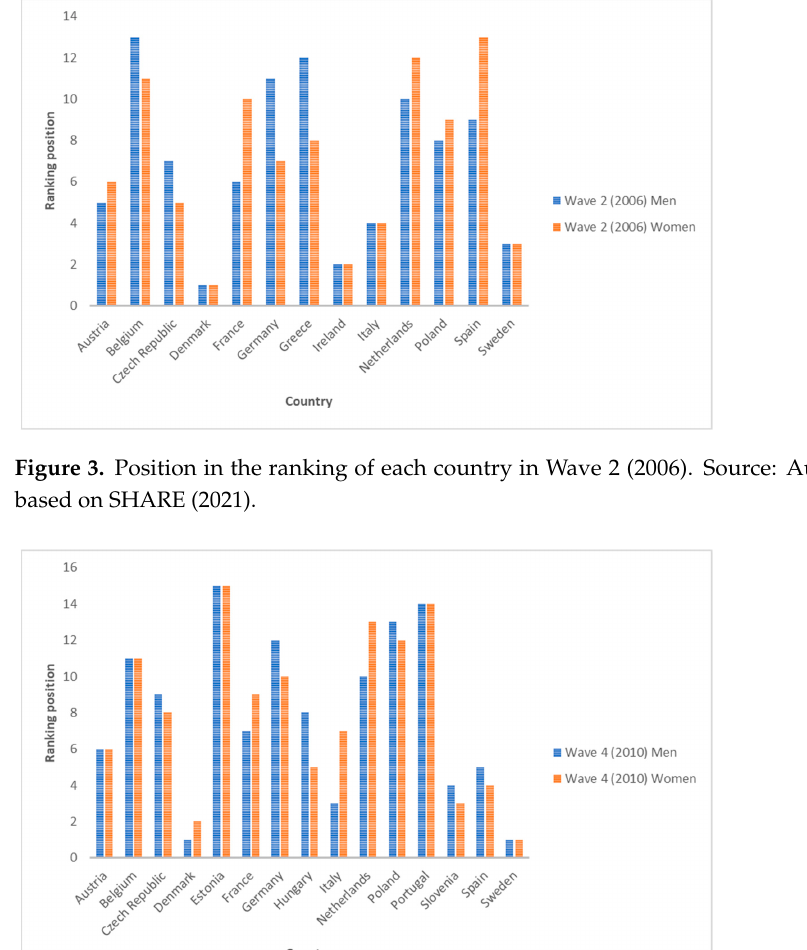
Figure 4. Position in the ranking of each country in Wave 4 (2010). Source: Authors’ elaboration based on SHARE (2021).